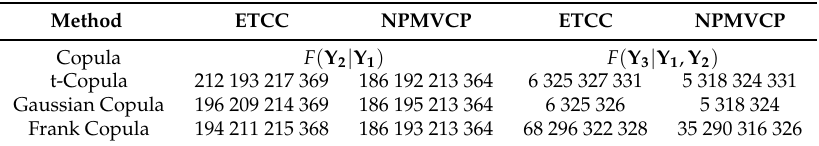
Table 8. Change point detection by ETCC and NPMVCP of PCA and copulas with simulated multivariate